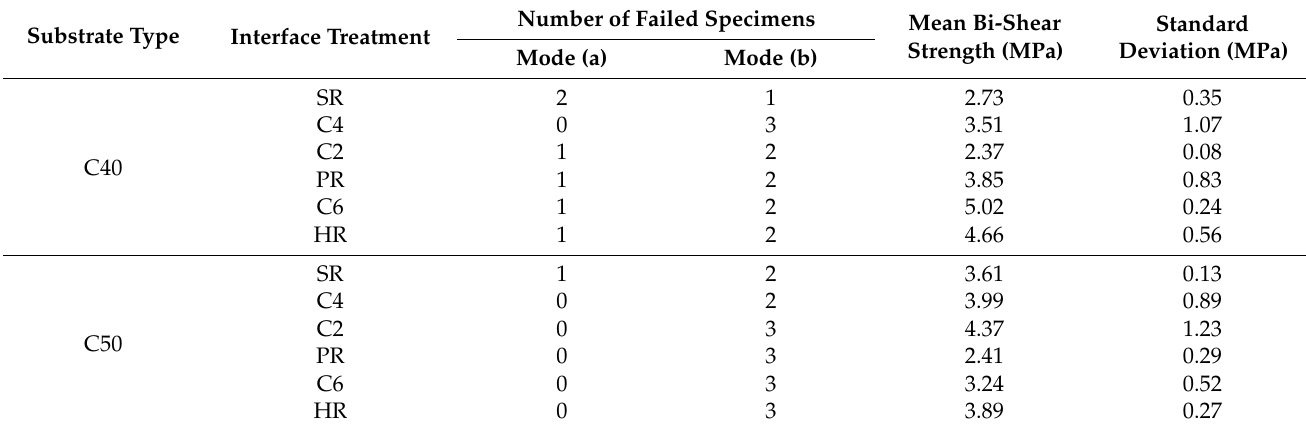
Table 4. Summary of the bi-shear test results.